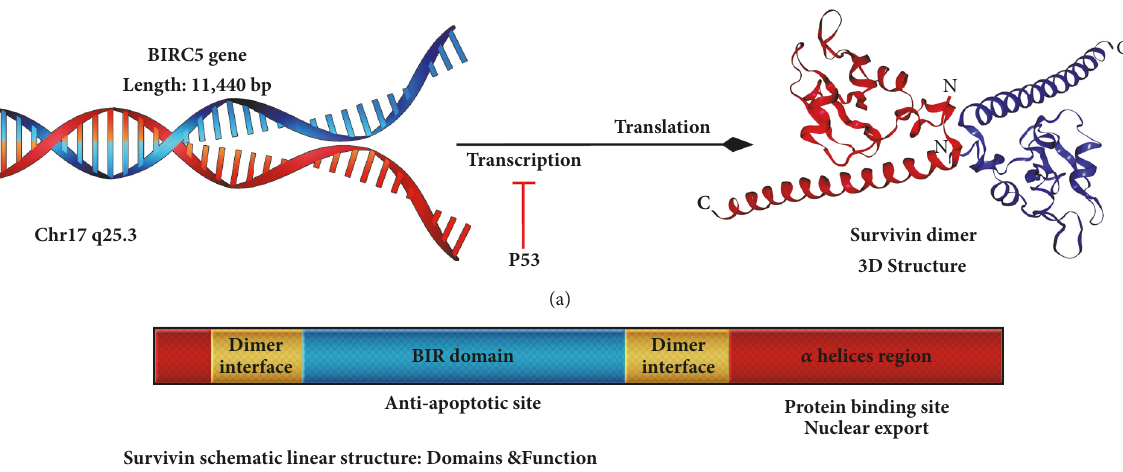
Figure 1: Survivin gene and protein structure. (a) The position of the gene and the relevant protein product with 3D dimer structure (base on PDB accession No.1e31) are shown. p53 protein plays an inhibitory role in the gene transcription. (b) The linear schematic structure of the survivin protein is shown along with the domains and roles of each. A BIR domain with antiapoptotic activity and an extended c-terminal alpha-helix region involved in protein interactions and nuclear